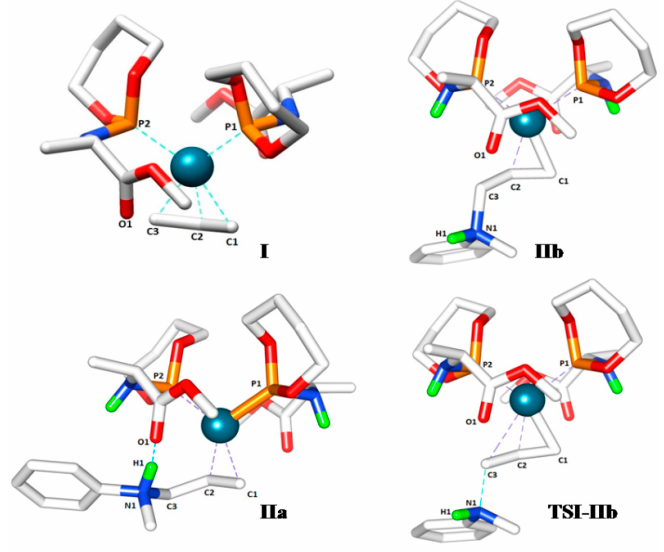
Figure 1. In all structures the related atoms are labeled such that C1 refers to the allyl carbon